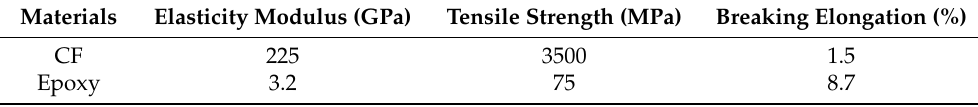
Table 1. Characteristic parameters of CF and